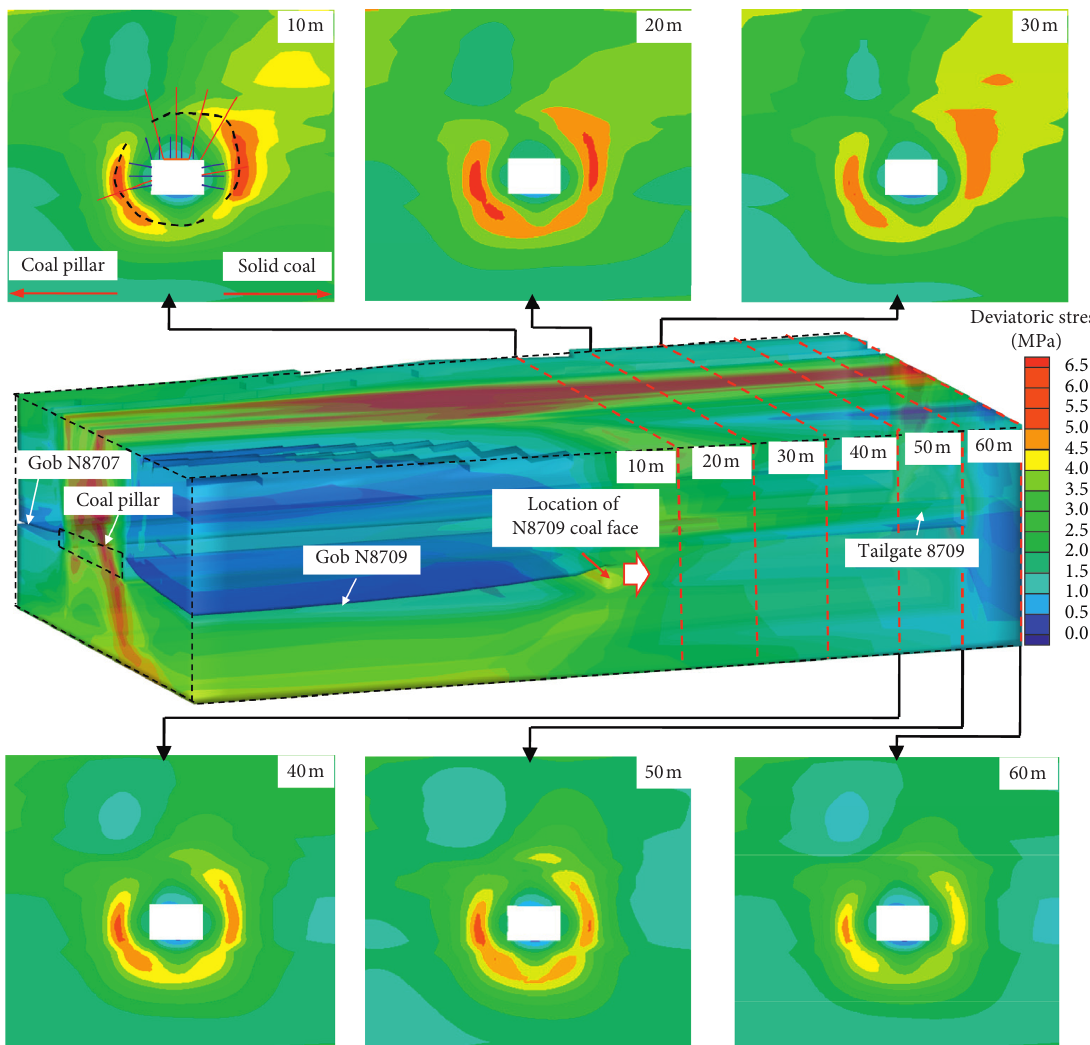
Figure 8: Nephograms of deviatoric stress of Tailgate 8709 in the mining process of the N8709 coal face in No. 11 coal